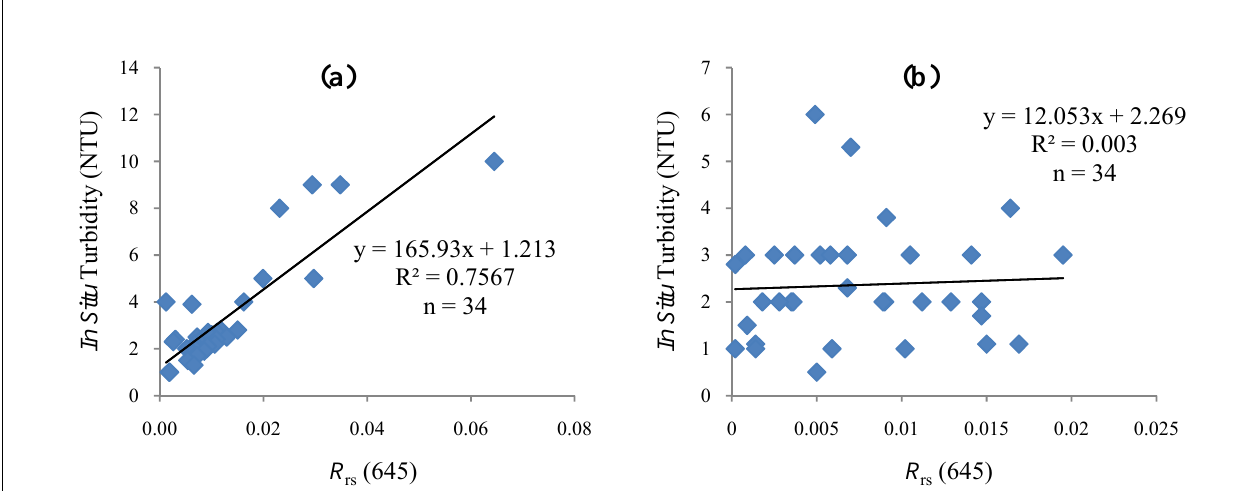
Figure 3. In situ turbidity (NTU) vs. R rain event. (b) Data collected day zero (cloud free